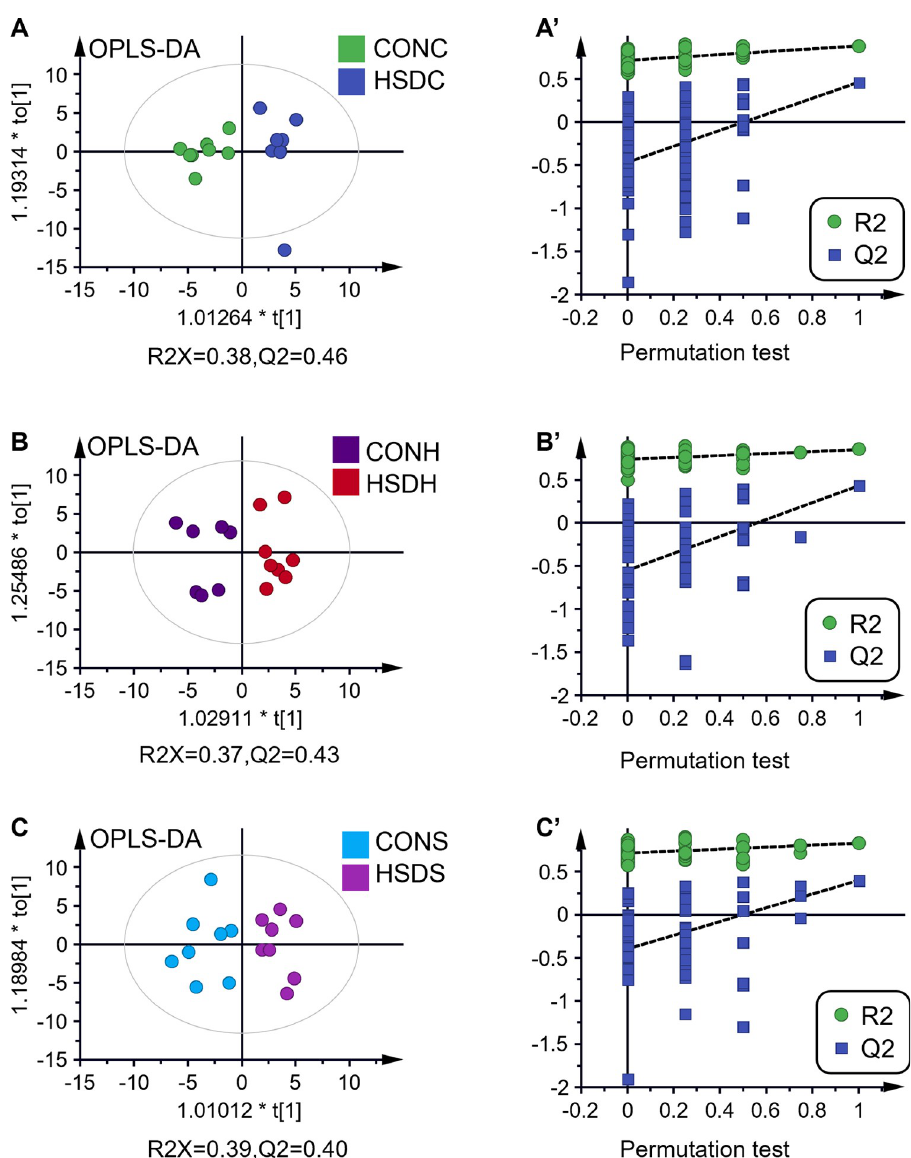
Fig 4. Orthogonal partial least squares discriminant analysis (OPLS-DA) score plots and permutation test plots that discriminate the effect of 400 msw heliox-saturation exposure on 1H NMR spectra from control groups in the cortex (CONC, n = 8, HSDC, n = 8, A and A’) (R2X = 0.38; Q2 = 0.46), hippocampus (CONH, n = 8, HSDH, n = 8, B and B’) (R2X = 0.37; Q2 = 0.43), and striatum (CONS, n = 8, HSDS, n = 8, C and C’) (R2X = 0.39; Q2 = 0.40). The values of the Q2 parameter in the OPLS-DA score plots, which were equal to or greater than 0.40, coupled with the Q2 values of the leftmost point in the permutated models were greater than all the fitted Q2 values of the right points (permutation test 80 times), indicating that the established OPLS-DA models were valid.